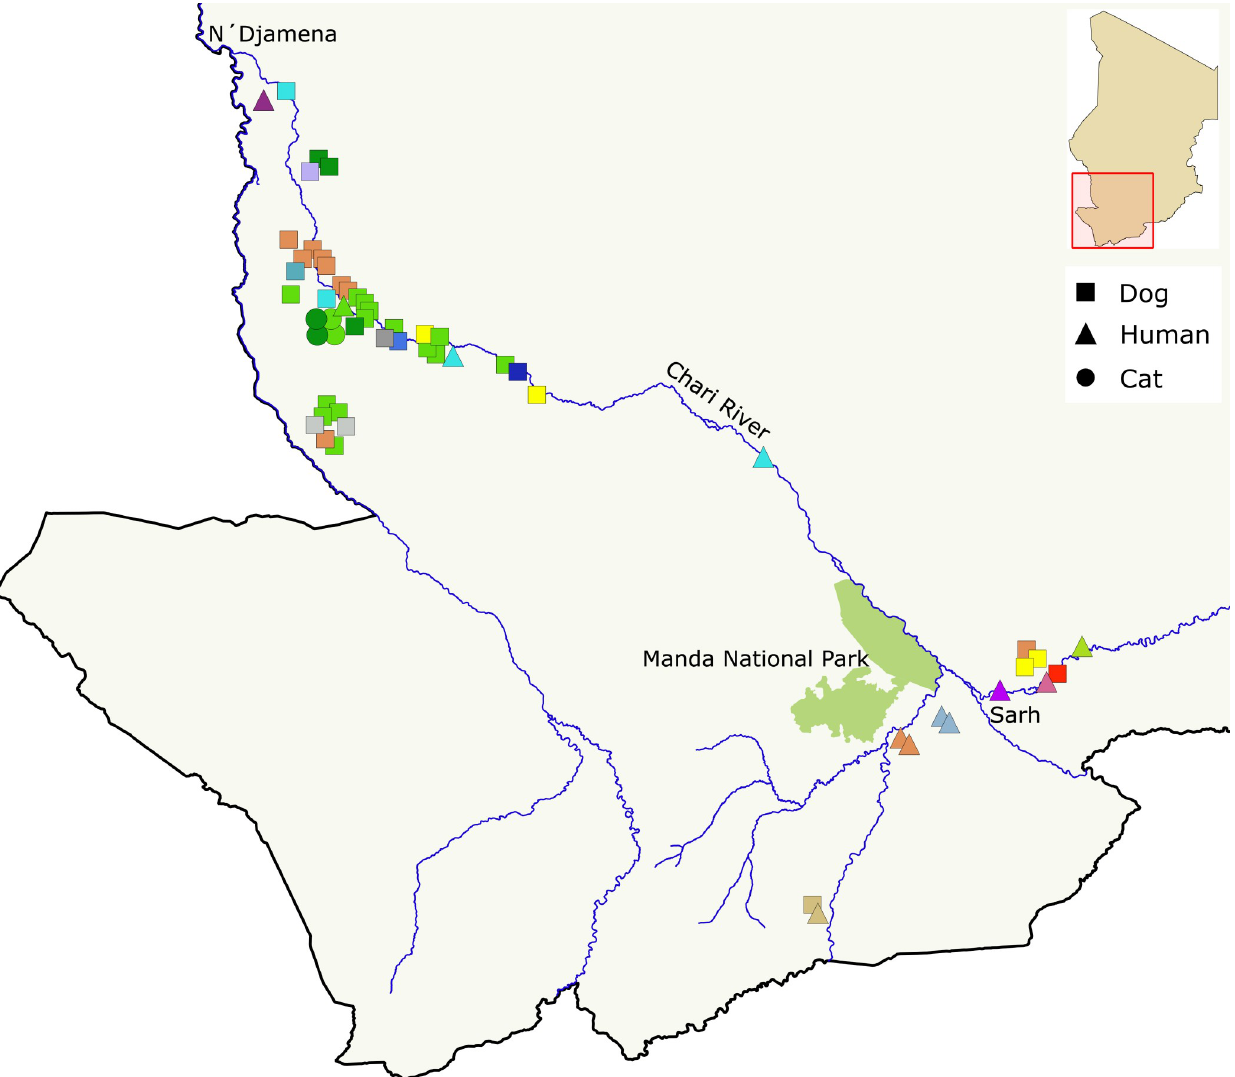
Fig 1. Distribution of mitochondrial haplotypes across Chad and among host species. Distribution of mitochondrial haplotypes across the geographic range and host species sampled in Chad. Host species are indicated by point shape and mitochondrial haplotype by color. The map was generated with QGIS v2.18.13 [46]. River paths and national park boundaries were extracted from Landsat 8 imagery provided courtesy of the U.S. Geological Survey (http://glovis.usgs.gov/).